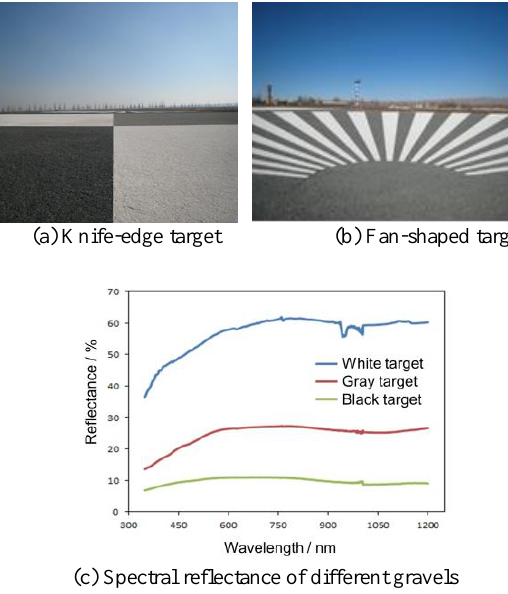
Figure 3. Permanent optical artificial targets